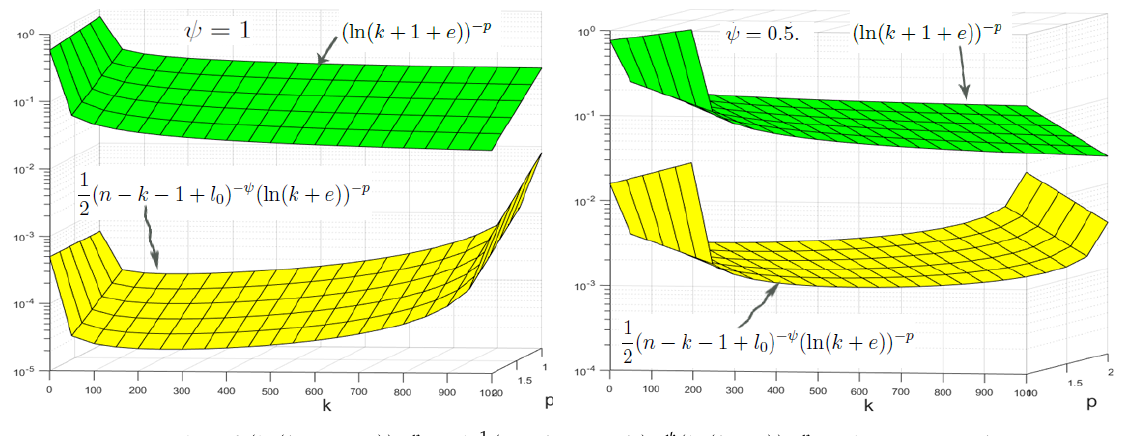
Figure 1. Plot of ( ln ( k + 1 + e )) − p and 1 and ( left ) ψ = 1 and ( right ) ψ = 0.5.